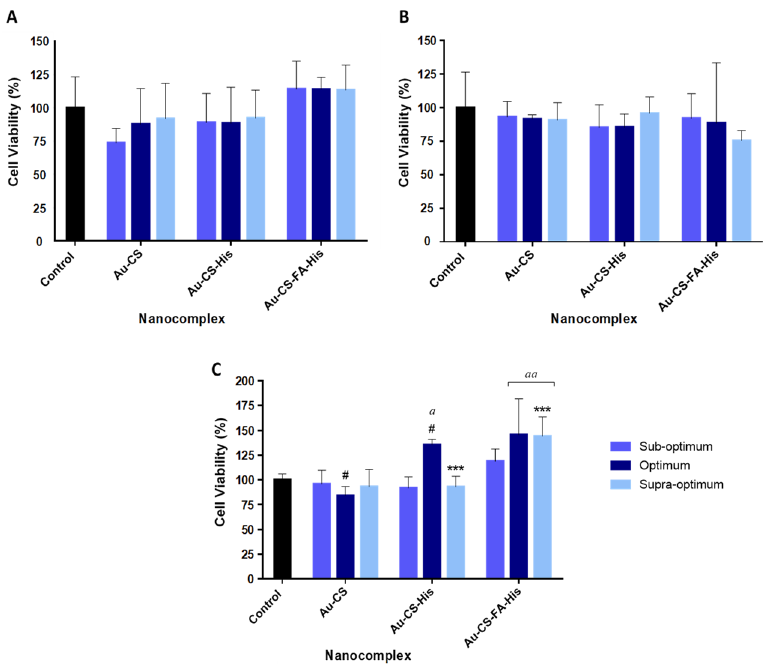
Figure 7. MTT cytotoxicity assay in the ( A ) HEK293, ( B ) SKBR3 and ( C ) MCF-7 cell lines. Data are represented as the mean ± SD ( n = 3). *** p < 0.001 shows statistical significance between correspond-